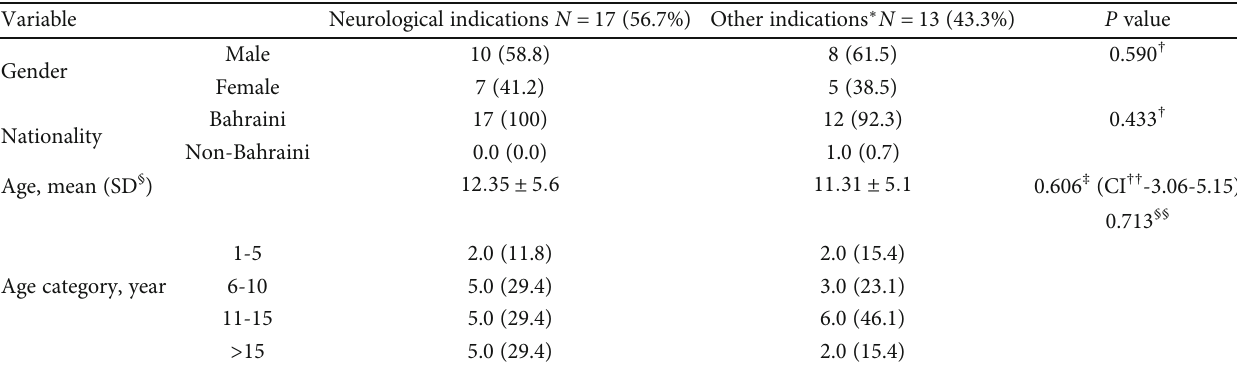
Table 1: Comparison between the neurological indications for button gastrostomy tubes for 30 pediatric patients and other indications in term of gender, nationality, and age category.